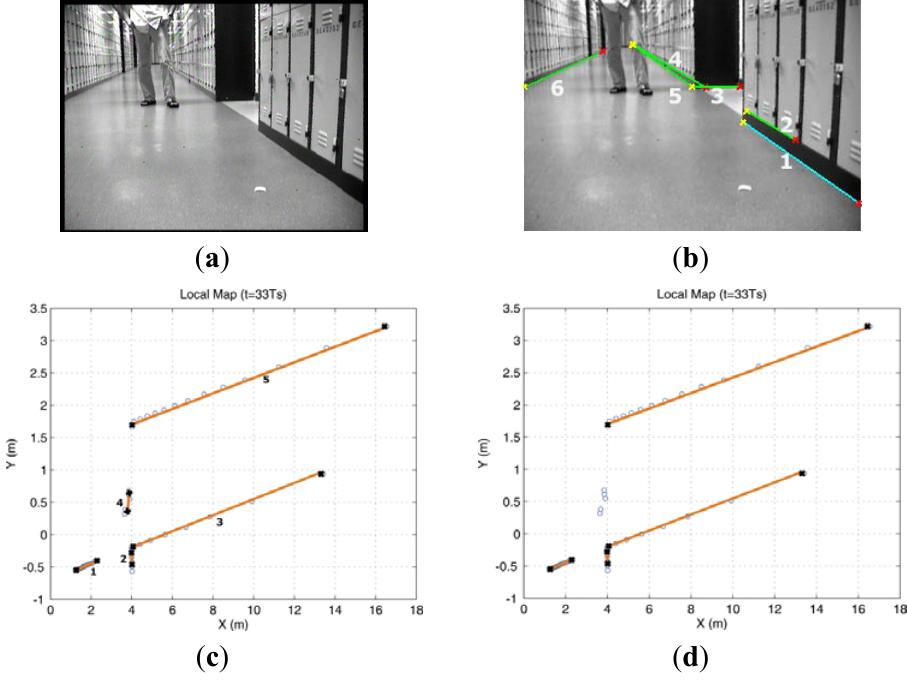
Figure 4. Local mapping result at the 33rd sample time. ( a ) The original captured image. A person stood in front of the robot for a moment. ( b ) The extracted image lines and their endpoints in ROI. The cyan line is the first extracted one and numbered as 1. ( c ) The extracted laser segments within the HFOV and a pseudo segment (segment 4) related to standing person. ( d ) After integrating the lines information extracted from images, the incorrect segment was